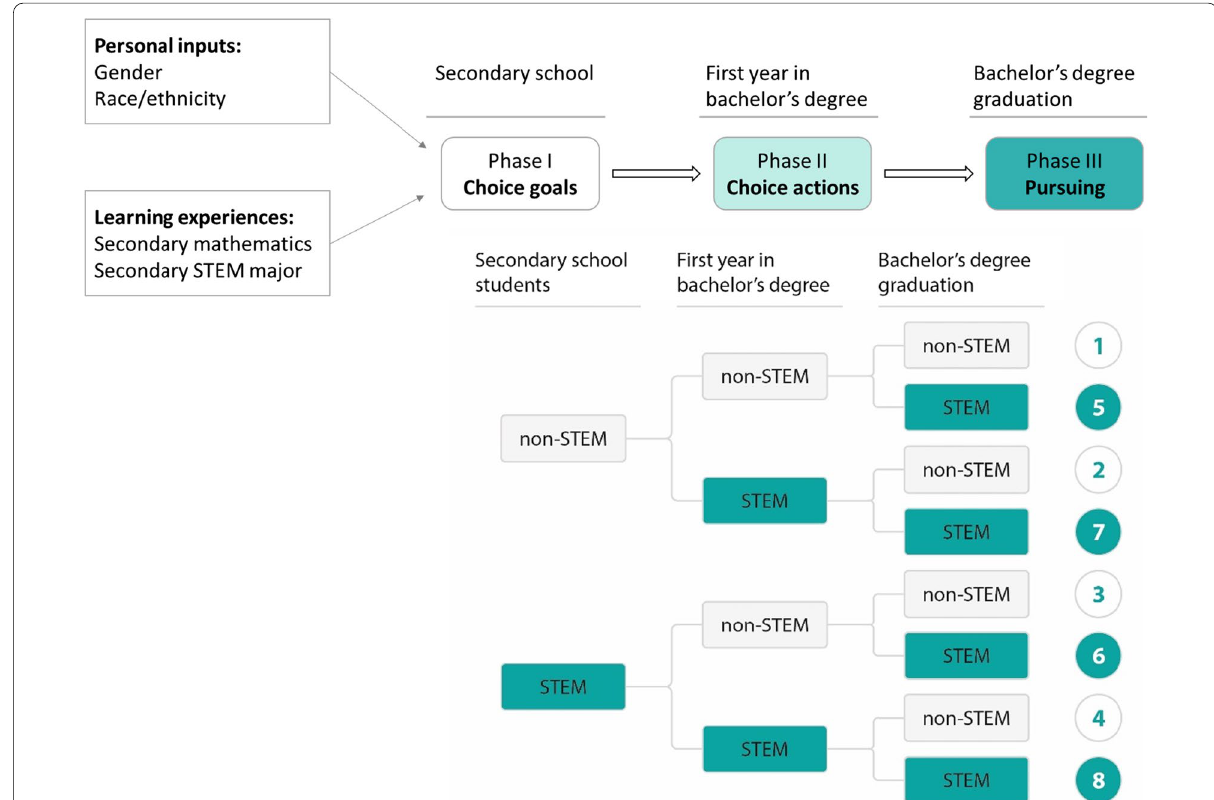
Fig. 10 The three‑tier tree established in this study, and its interrelation to the CSM model (Lent & Brown, 2013)